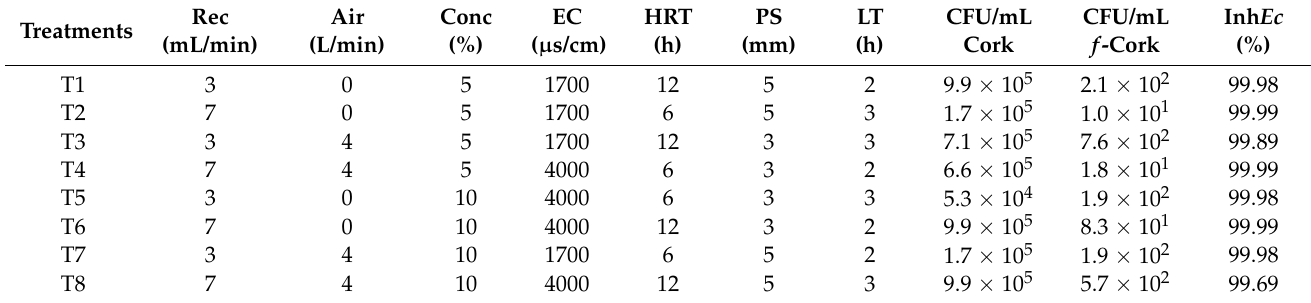
Table 3. Effect of cork functionalized with Mo Se on the inhibition of E. coli